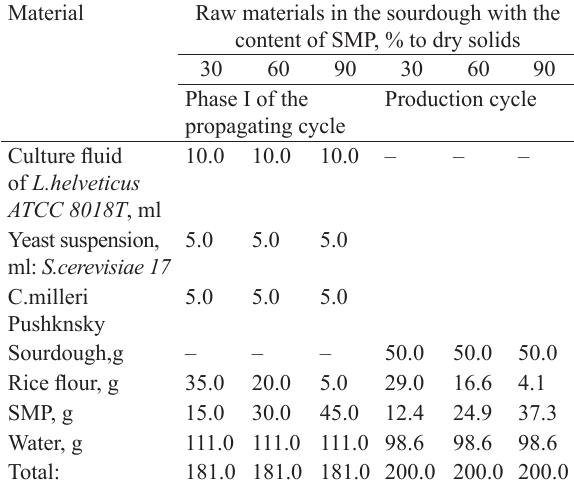
Table 2 Sourdough formulae with SMP and pure cultures of yeast and LAB Material Raw materials in the sourdough with